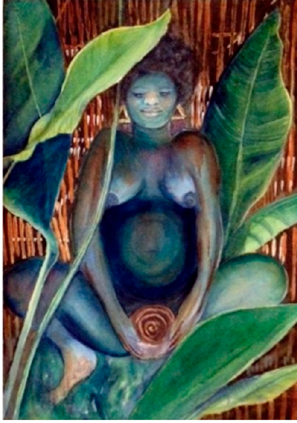
Figure 5 . Girl in Bamboo Earrings , watercolor